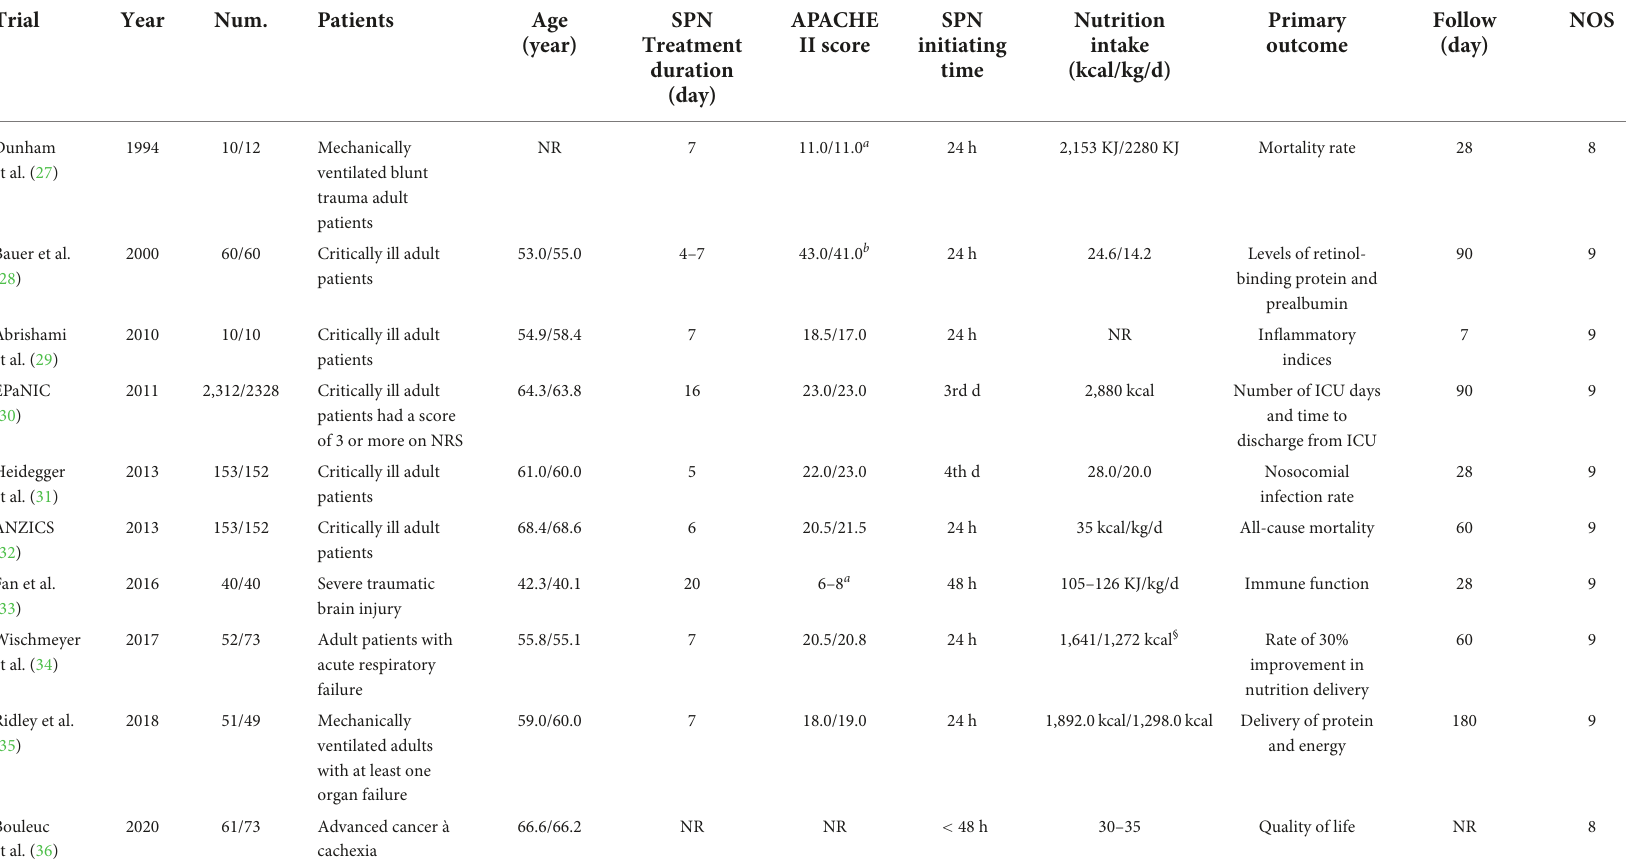
TABLE 1 Basic clinical characteristics of patients